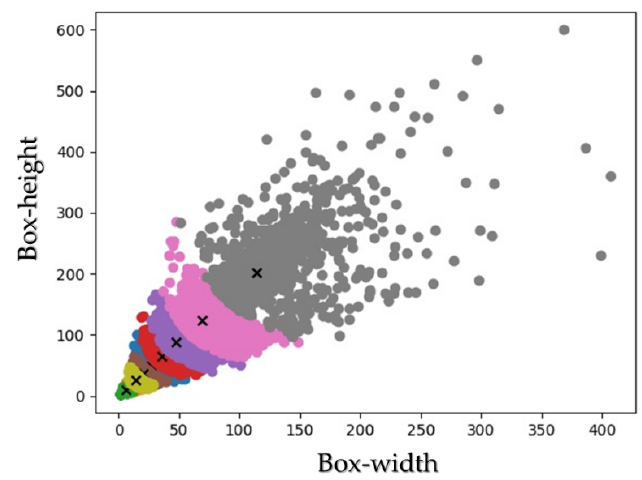
Figure 11. The K-means clustering derives the clusters of height and width of the anchor boxes. Table 2. The anchor mask setting parameters are derived from Figure 11.